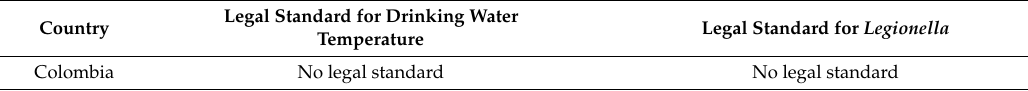
Table 2. Legal standards and monitoring of the surveyed